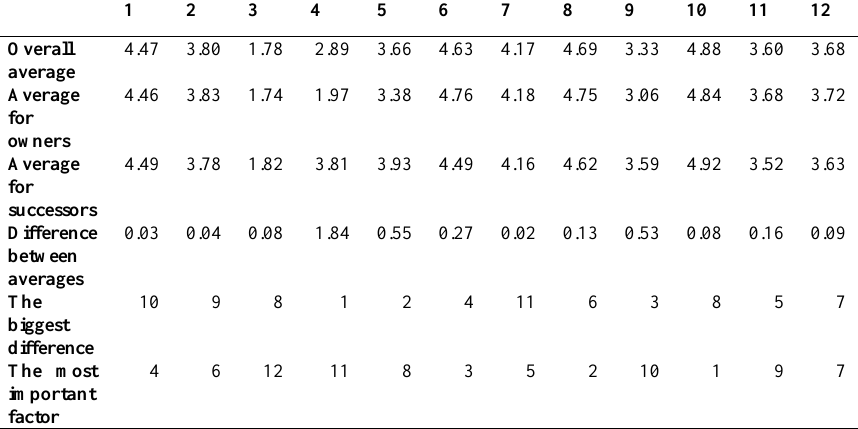
Table 3. Average responses